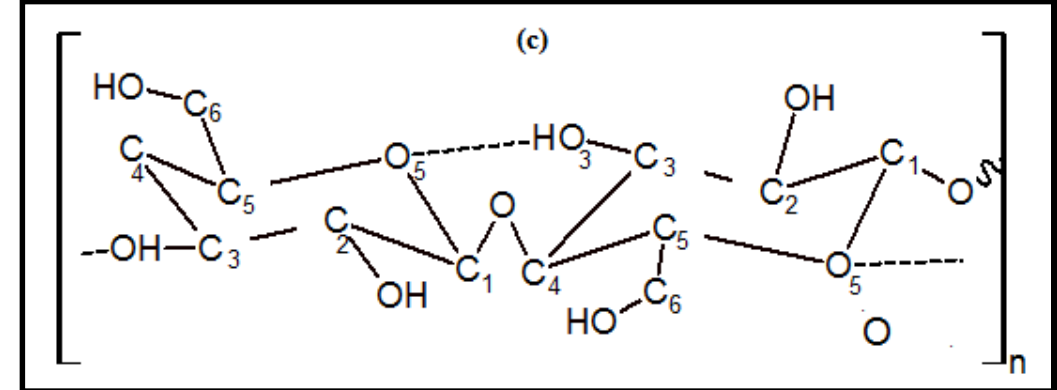
Figure 1. Chemical structure of ( a ) hydroxyapatite (HA); ( b ) tricyclic phosphate (β-TCP); and ( c ) cellulose.